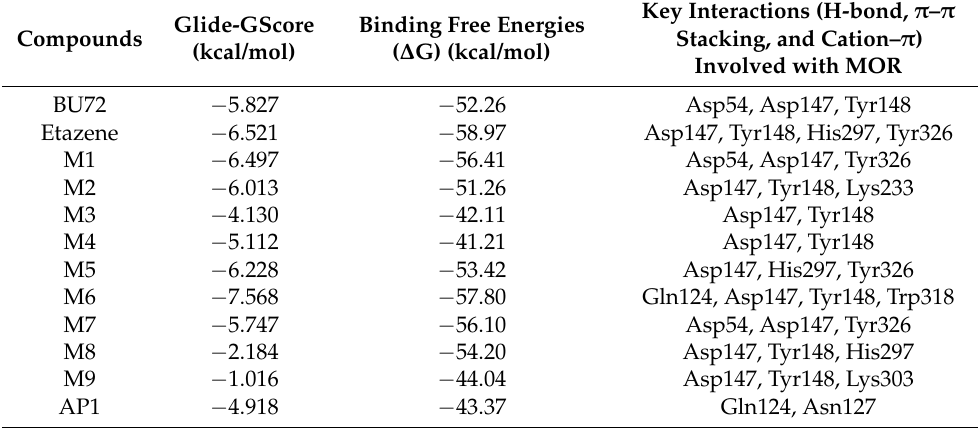
Table 1. Docking scores and key amino acid residues involved in the interactions of etazene and its metabolites with the